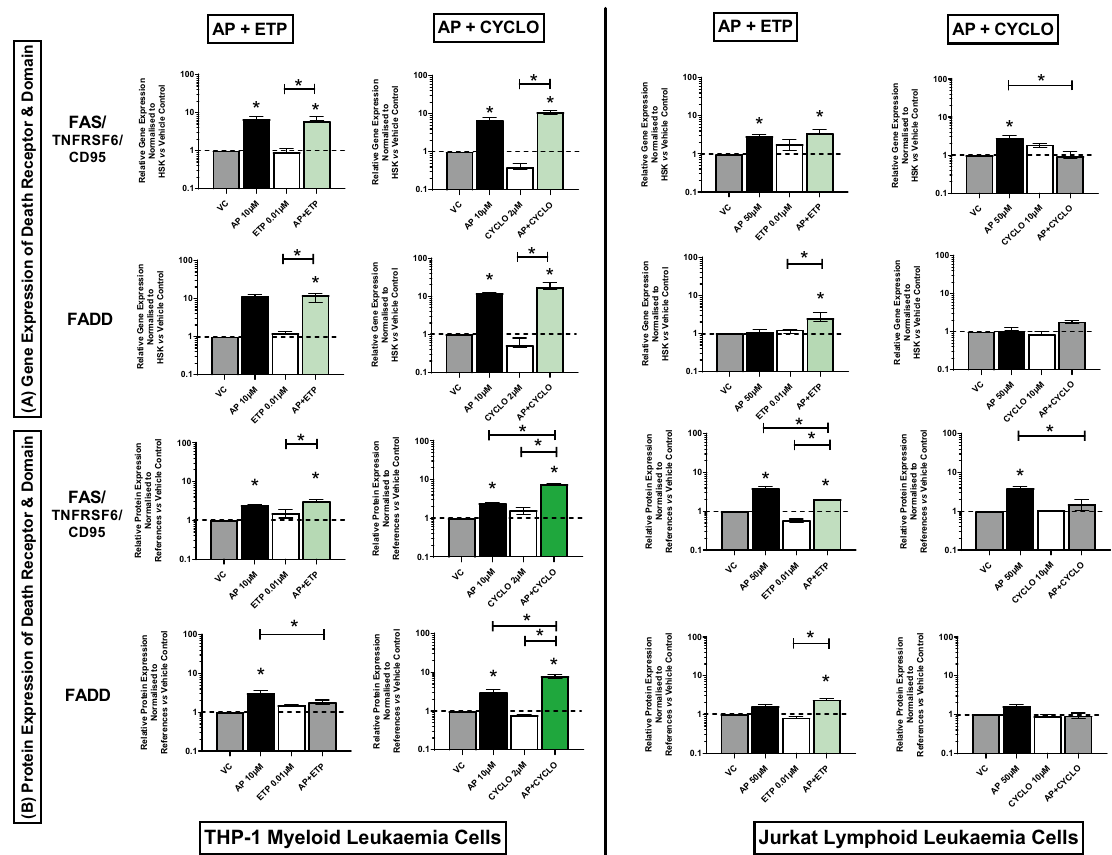
Figure 6. Effects of apigenin (AP) alone and in combination with etoposide (ETP) and cyclophosphamide (CYCLO) on expression of FAS/CD95 death receptor and FADD domain genes ( A ) and proteins ( B ) in acute myeloid (THP-1) and lymphoid (Jurkat) leukaemia cell lines when treated with their lowest significant doses (LSDs) that induce apoptosis (determined previously in Mahbub et al., 2013, 2015, 2019) for 24 h. Gene and protein data are expressed as medians and ranges. Results were considered statistically significant when P ≤ 0.05 (*). The combination treatment effects and colours were determined based on the statistical analysis as described